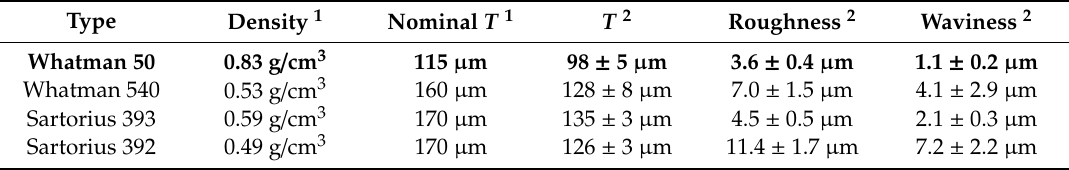
Table 3. Summary of quantitative filter properties considered. The most favorable values (highest for density; lowest for all others) are bolded in each